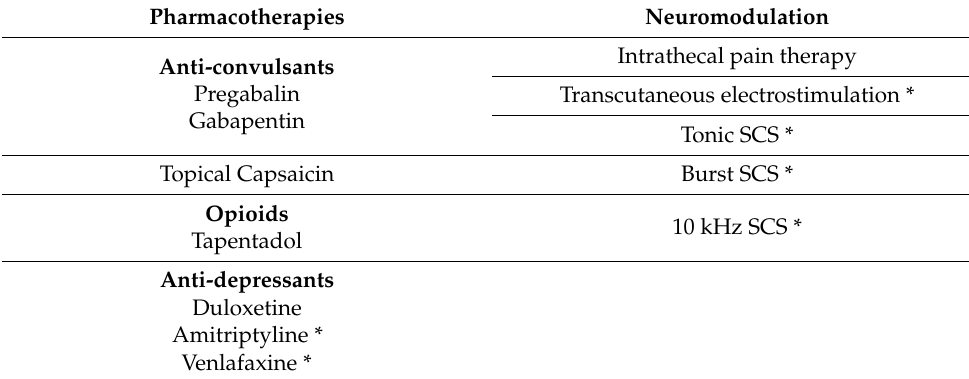
Table 1. Therapeutic options for painful diabetic